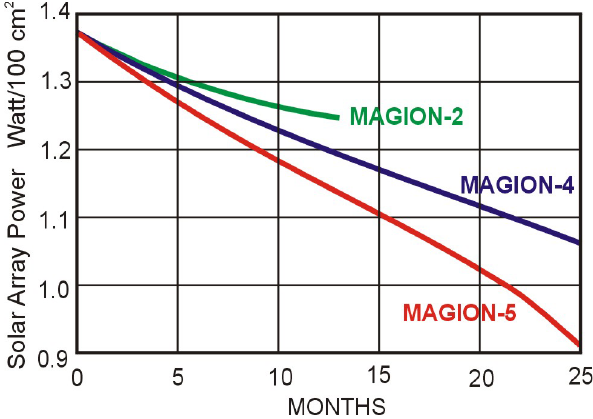
Fig. 3. MAGION-4 and MAGION-5 solar array degradation during the 25 months after launch. Most of the differences between these two curves can be explained by the effect of the radiation belts, which is more than 10 times stronger along the orbit of MAGION-5 than MAGION-4. The solar array degradation curve measured on the low-orbiting MAGION-2 (apogee 2400km) is shown for com-